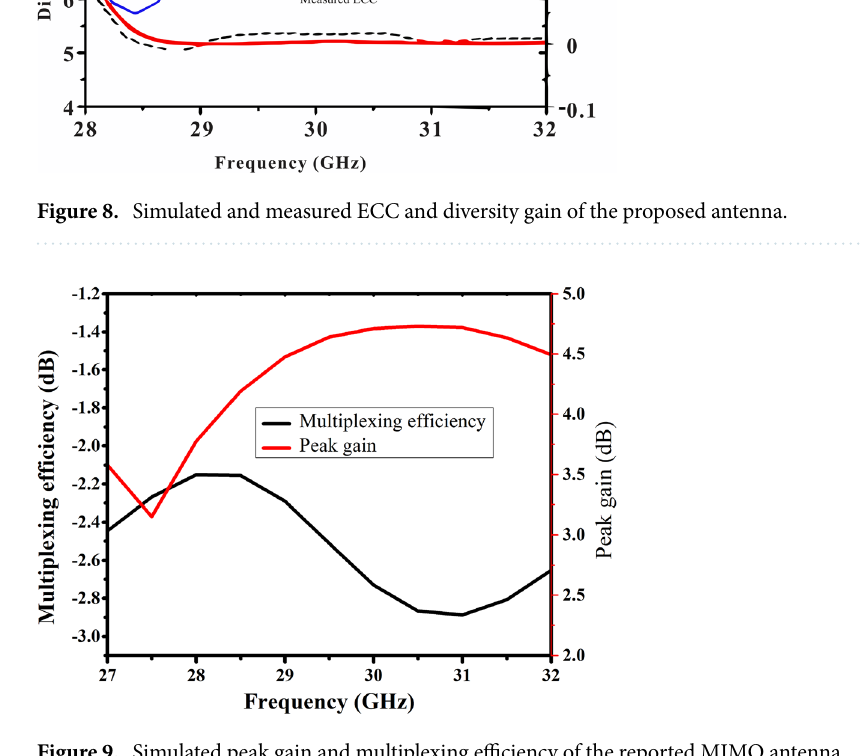
Figure 9. Simulated peak gain and multiplexing efficiency of the reported MIMO